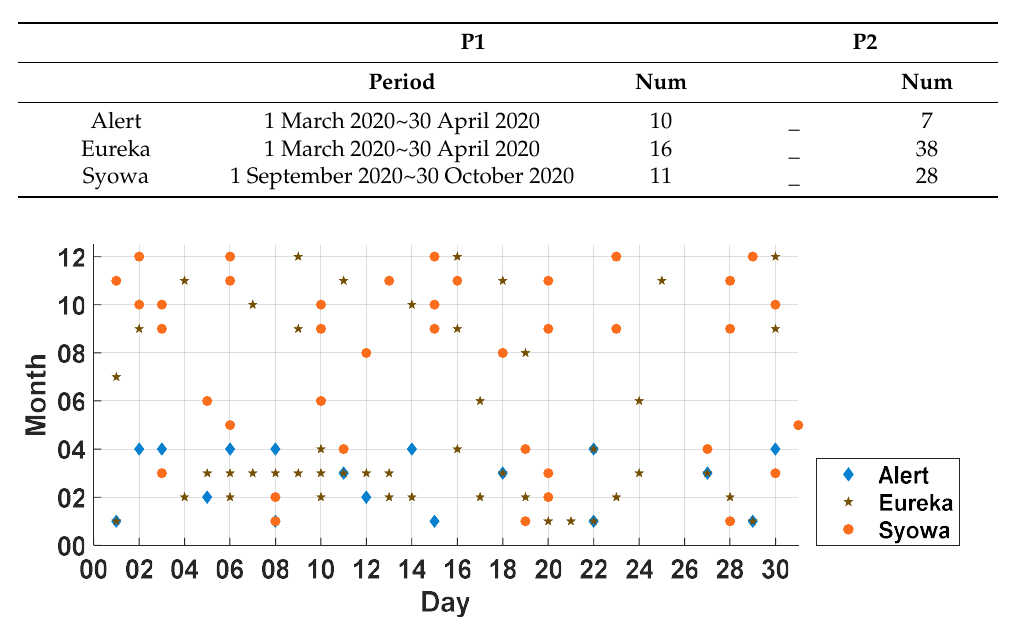
Figure 8. The observation time distribution at Alert, Eureka, and Syowa stations.